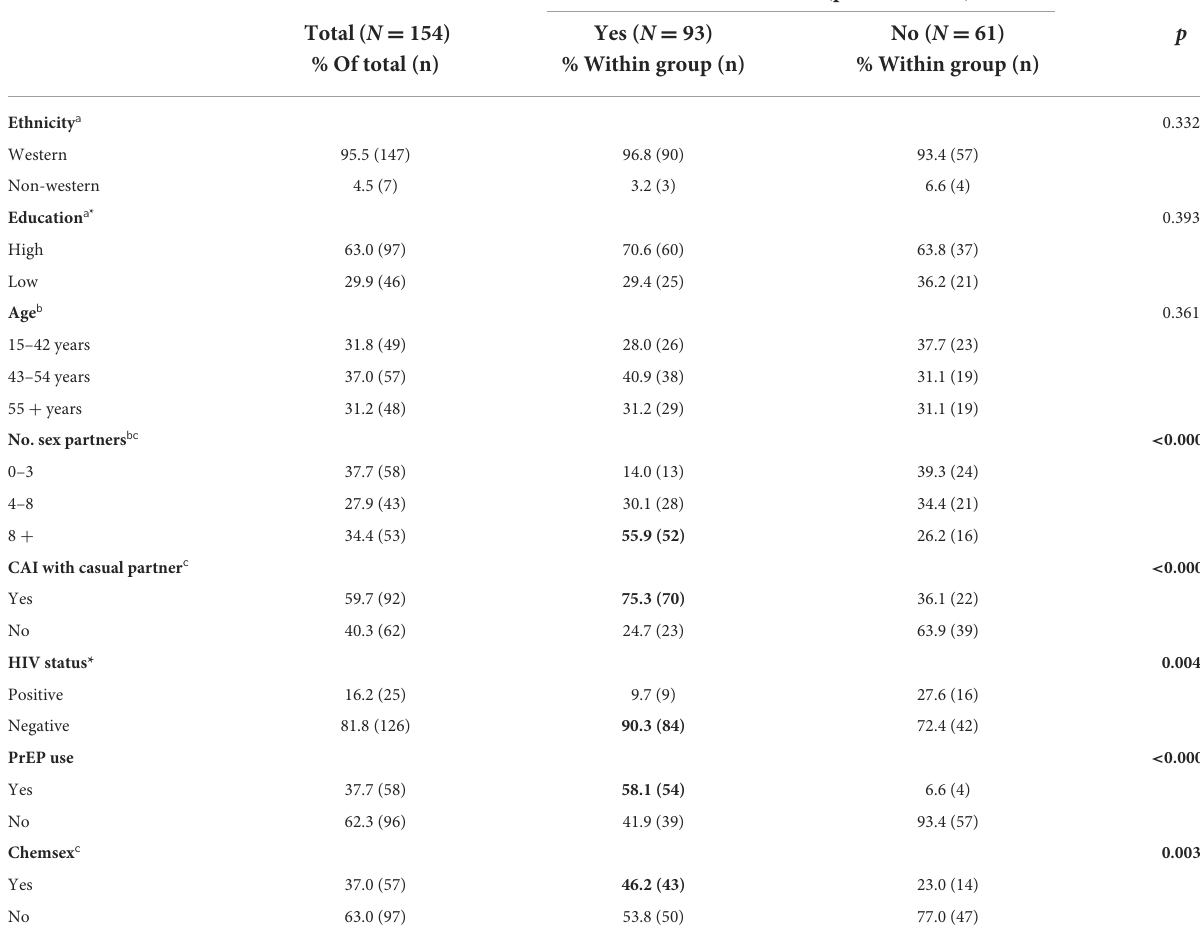
TABLE 2 Characteristics study sample of men who have sex with men who previously attended clinic-based sexual health care in the Netherlands. Recent STI/HIV test (past 6